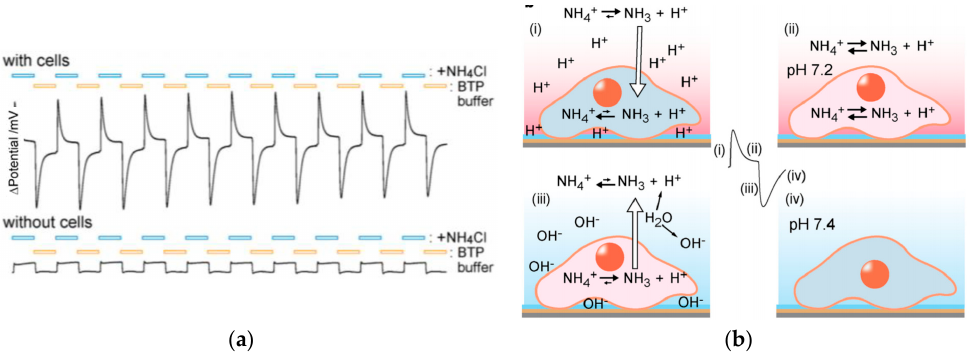
Figure 10. ( a ) Time-course of the ISFET potential difference (between gate and drain) during